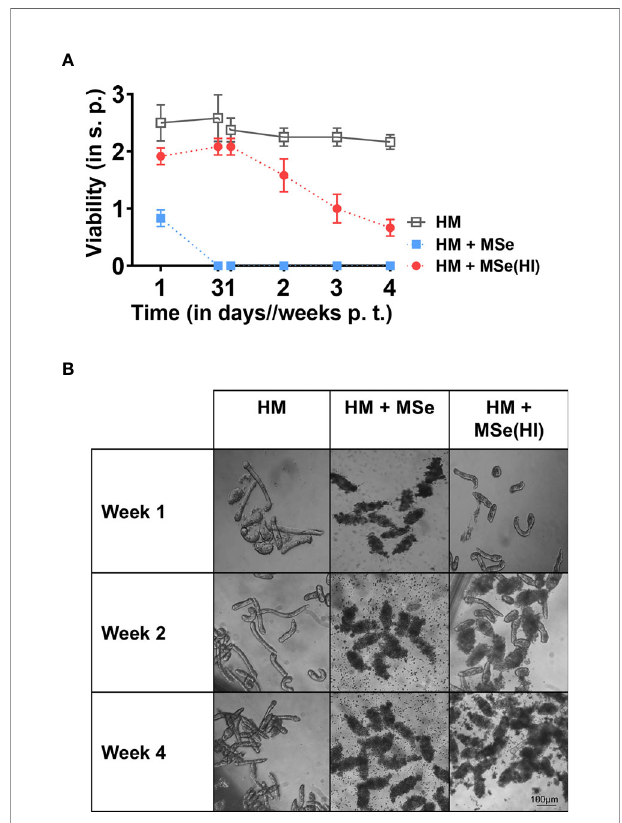
FIGURE 3 | Rapid killing effects of mouse serum are mainly due to heat labile factors. NTS were cultured in hybridoma medium (HM) supplemented or not with 20% of native (MSe) or heat-inactivated (56°C for 30 min) (MSe(HI)) mouse sera at 37°C in 5% CO 2 for four weeks. Supplemented medium was refreshed weekly. HM alone was used as a control. (A) Survival of NTS is prolonged by heat inactivation of serum. Viability scoring was performed at the indicated time points. Results are representative of at least three individual experiments. Each data point has been shown as mean ± SD of at least three technical replicates. (B) Morphological changes of NTS induced by MSe with and without heat inactivation. Representative photographs of NTS were taken from the NTS cultured using a digital camera fi tted with an inverted microscope (10x). p.t., post transformation; s.p., scoring